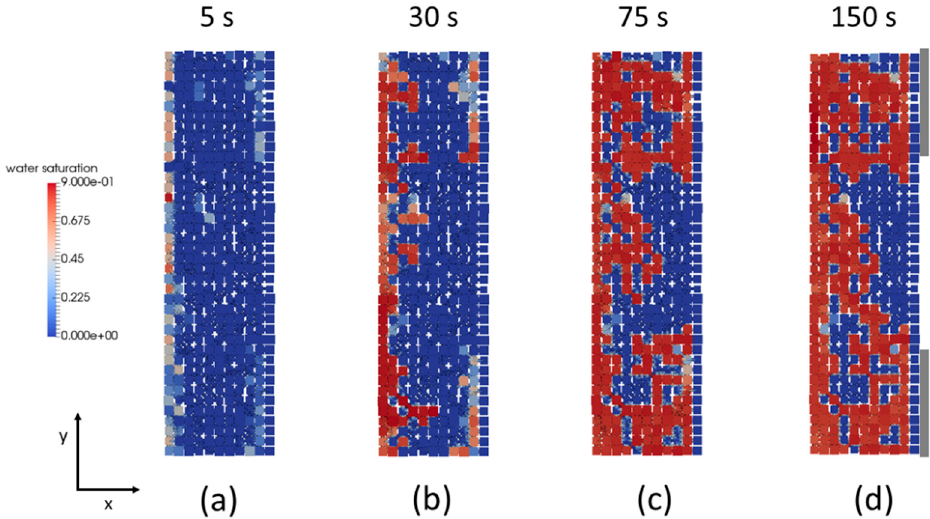
Figure 9. Temporal evolution of water saturation and liquid water clusters in the GDL in case 3. In comparison to the parameters used in case 1, the operating temperature was set to 60 °C.